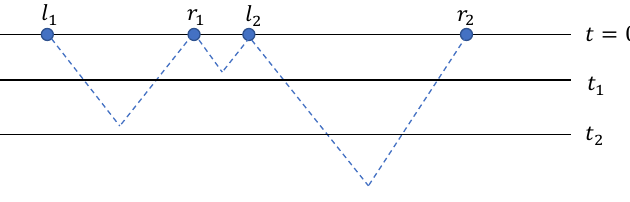
Figure 11 . We show an example to explain the notation of equation (3.13). At time t 1 , the only connectable pair is { l 2 , r 1 } , whereas at time t 2 , { l 2 , r 1 } and { l 1 , r 1 } are both connectable pairs. The allowed configurations in the set { γ } ( t 2 ) are γ 1 = { l 1 , r 2 , { l 2 , r 1 }} , γ 2 = { l 2 , r 2 , { l 1 , r 1 }} , and γ 3 = { l 1 , r 1 , l 2 , r 2 }